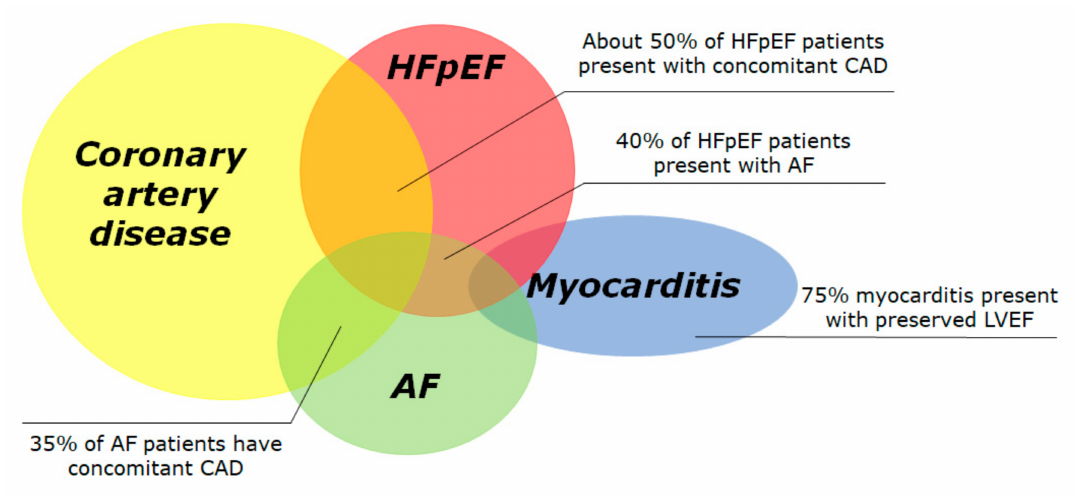
Figure 1. Prevalence of conditions associated with preserved left ventricular ejection fraction and increased risk of sudden cardiac death. The Venn diagram displays the four most frequent conditions associated to sudden cardiac death, i.e., coronary artery disease, heart failure with preserved ejection fraction, atrial fibrillation and acute myocarditis. Many conditions overlap with others. The overall incidence of SCD in each subgroup is largely unknown due to difficult data collection. AF: atrial fibrillation; HFpEF: heart failure with preserved ejection